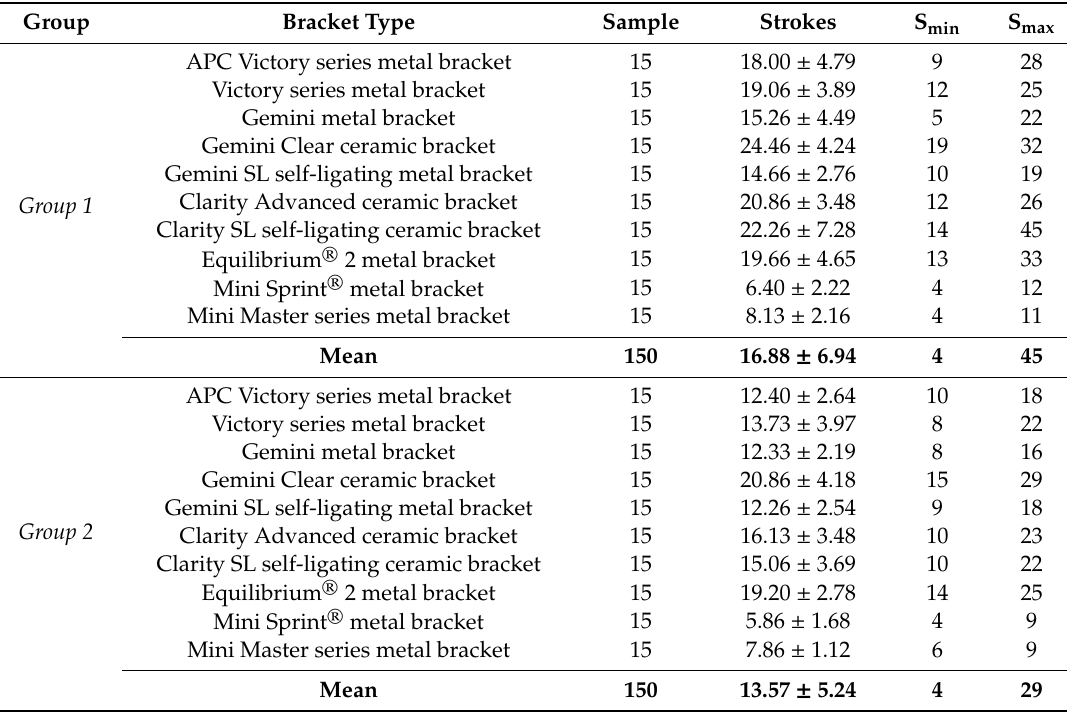
Table 5. Values of shearing strokes (S) of